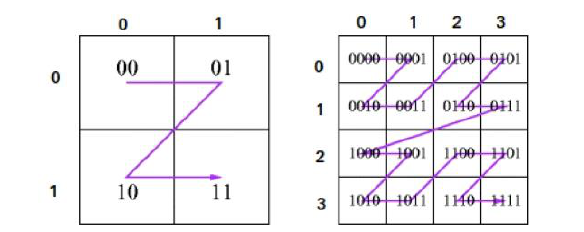
Figure 1. The first and second order of the Morton curve. In each cell, the corresponding key is shown.